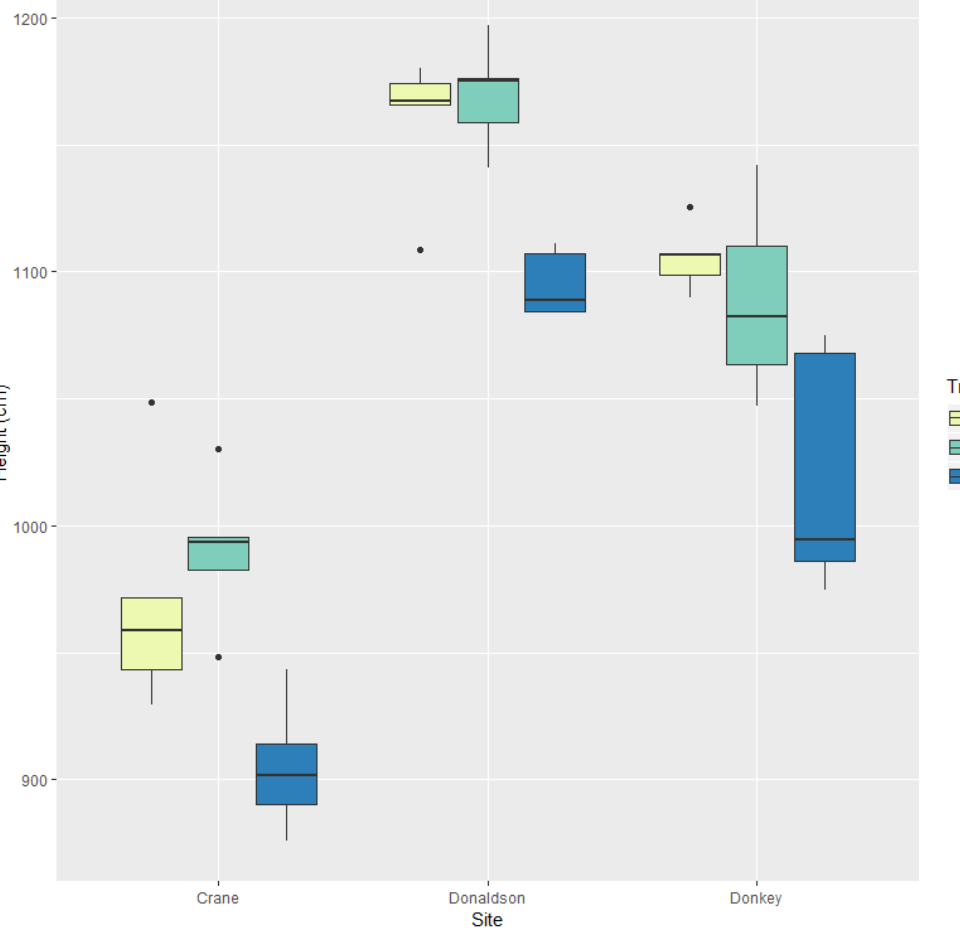
Figure 1. Tree heights, measured in 2017, across di ff erent sites and genetic gain levels.